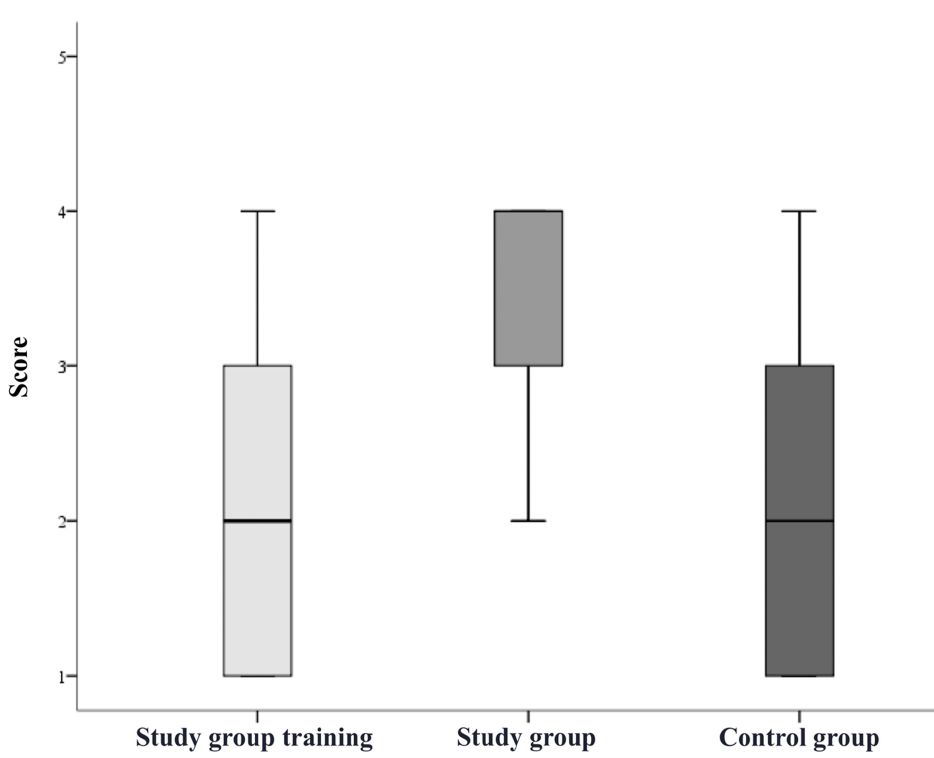
Figure 7. Grading of VUS-guided angioplasty of anastomosis. Legend: score range 1–5.